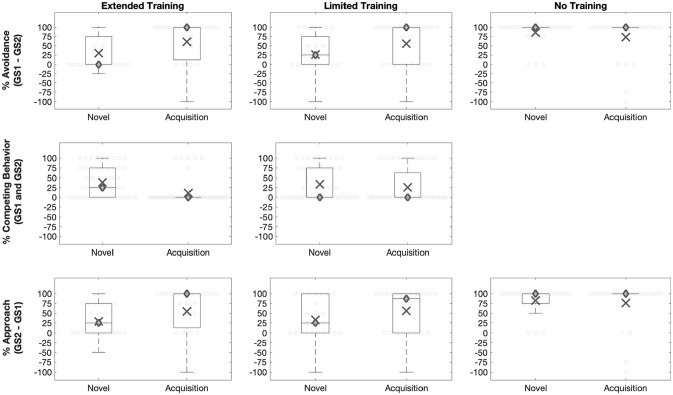
Outcome Measures: Generalised avoidance. Generalised avoidance was estimated as responding to GS1 relative to GS2. A positive score indicates more avoidance of GS1. A negative score indicates more avoidance of GS2. In the Extended and Limited Training groups, relative avoidance of GS1 was greater in the Acquisition context than in the Novel context. In the No-Training group, relative avoidance of GS1 did not differ between the Novel context and the Acquisition context. Competing behaviours. There was no effect of stimulus on competing behaviour. Overall, competing behaviours were more frequent in the Novel context than in the Acquisition context. Generalised approach. Generalised approach was estimated as responding to GS2 relative to GS1. A positive score indicates more approach of GS2. A negative score indicates more approach of GS1. In the Extended and Limited Training groups, relative approach of GS2 was greater in the Acquisition context than in the Novel context. In the No-Training group, relative avoidance of GS2 did not differ between the Novel context and the Acquisition context. ○ = Individual data points; X = mean; ◊ = median. Edges of the box are the 25th and 75th percentiles. Whiskers extend to extreme value not considered to be an outlier. The absence of a box indicates that the 25th and 75th percentiles overlapped with the median value.